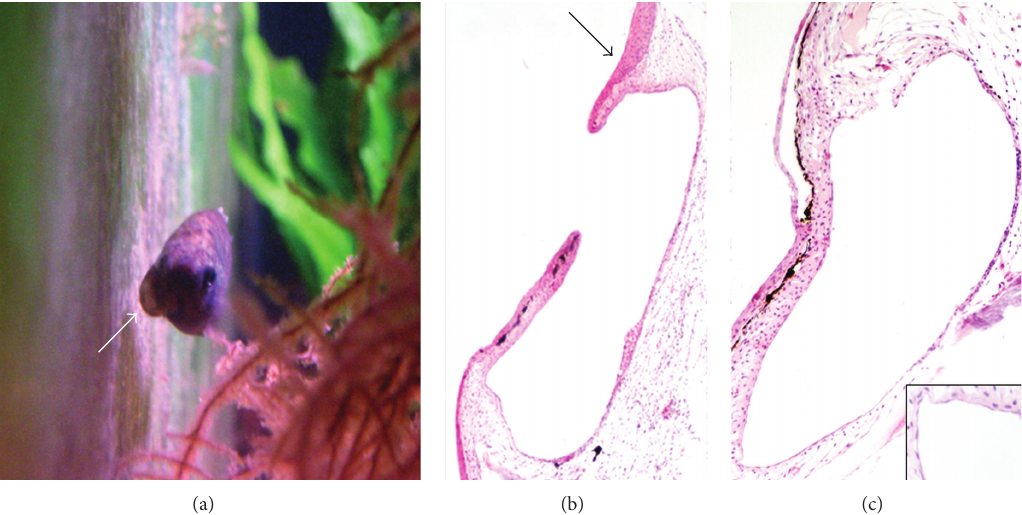
Figure 6: Adult female with a sub-ocular fluid-filled sac (arrow) (a); cystic cavity of the sac in continuity with the overlying hyperplastic epidermis (arrow) at the rupture site of the cyst wall (b); dermal lymphatic vessel located at the opposite cranium side; inset : magnified view of the endothelial lining of the lymphatic vessel (c) (H&E, (b) 10x, (c) 20x, inset